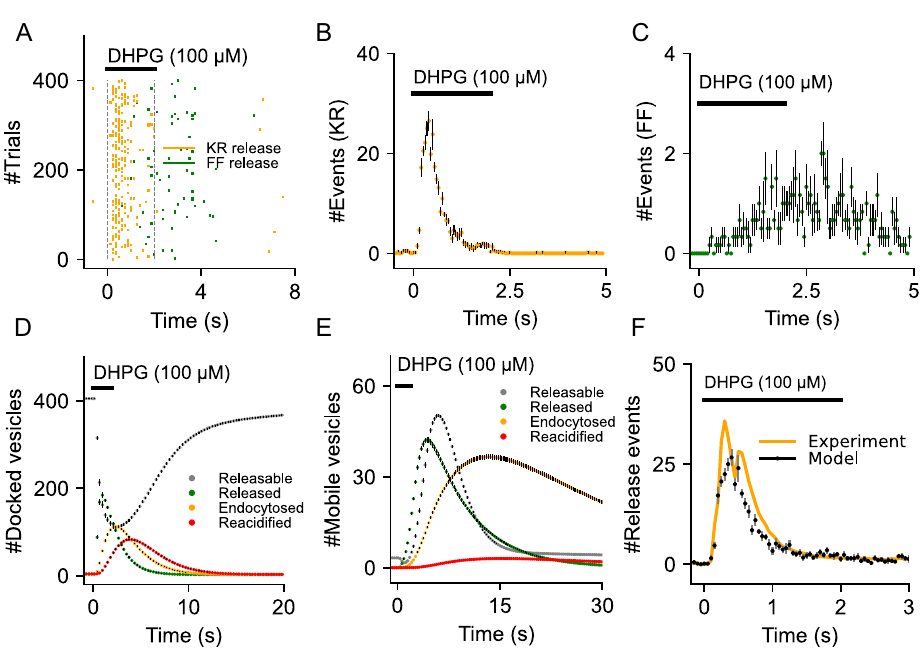
Fig 3. Validation of the gliotransmitter release model. (A) Raster plot of kiss-and-run and full fusion releases from an astrocytic compartment stimulated with DHPG (100 μ M, 2 sec). (B) Distribution of kiss-an-run release times shows the rapid rise in release events that decay exponentially within the stimulus duration. (C) Temporal distribution indicates the comparatively slow and low number of full-fusion events that extends beyond the stimulus duration. (D) Time courses indicate the dynamics of docked vesicle release, endocytosis and reacidification. (E) Time courses indicate the dynamics of mobile vesicle release, endocytosis and reacidification. (F) Temporal distribution of total release events is in good agreement with experimental data from Marchaland et al. (Marchaland et al., 2008a). Error bars indicate the standard error of the mean computed from 6 independent sets of simulation trials.